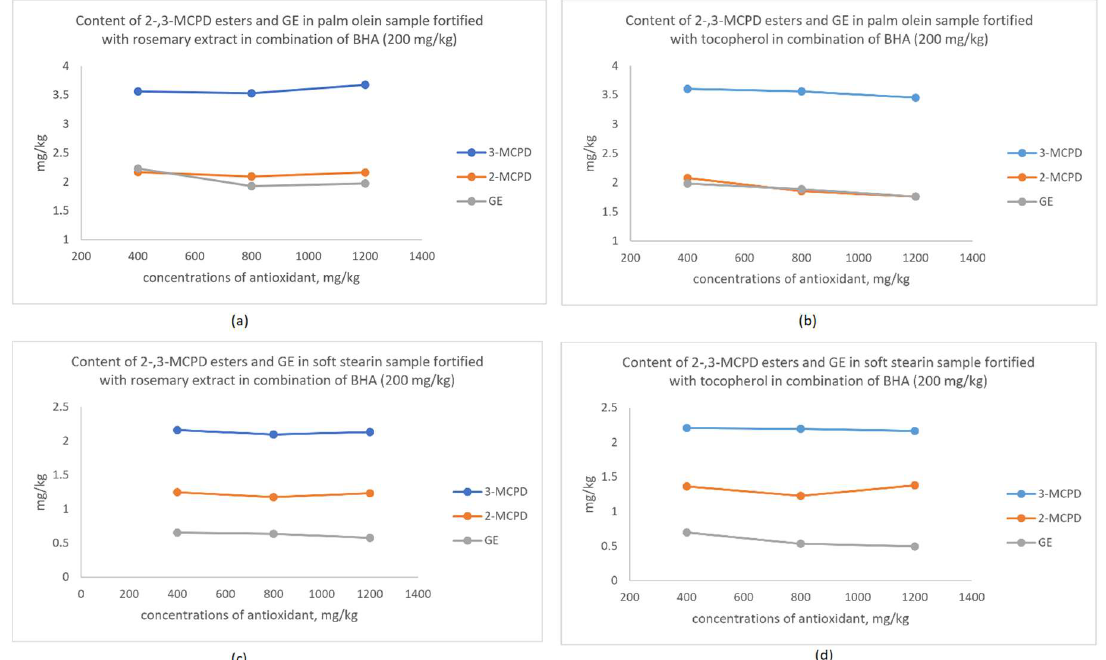
Figure 2. ( a ) Changes of 3- and 2-MCPD esters and GE content in a palm olein sample with different concentrations of rosemary extract and BHA (200 mg/kg). ( b ) Changes in 3- and 2-MCPD esters and GE content in a palm olein sample with different concentrations of tocopherol and BHA (200 mg/kg). ( c ) Changes of 3- and 2-MCPD esters and GE content in a soft stearin sample with different concentrations of rosemary extract and BHA (200 mg/kg). ( d ) Changes of 3- and 2-MCPD esters and GE content in a soft stearin sample with different concentrations of tocopherol and BHA (200 mg/kg).